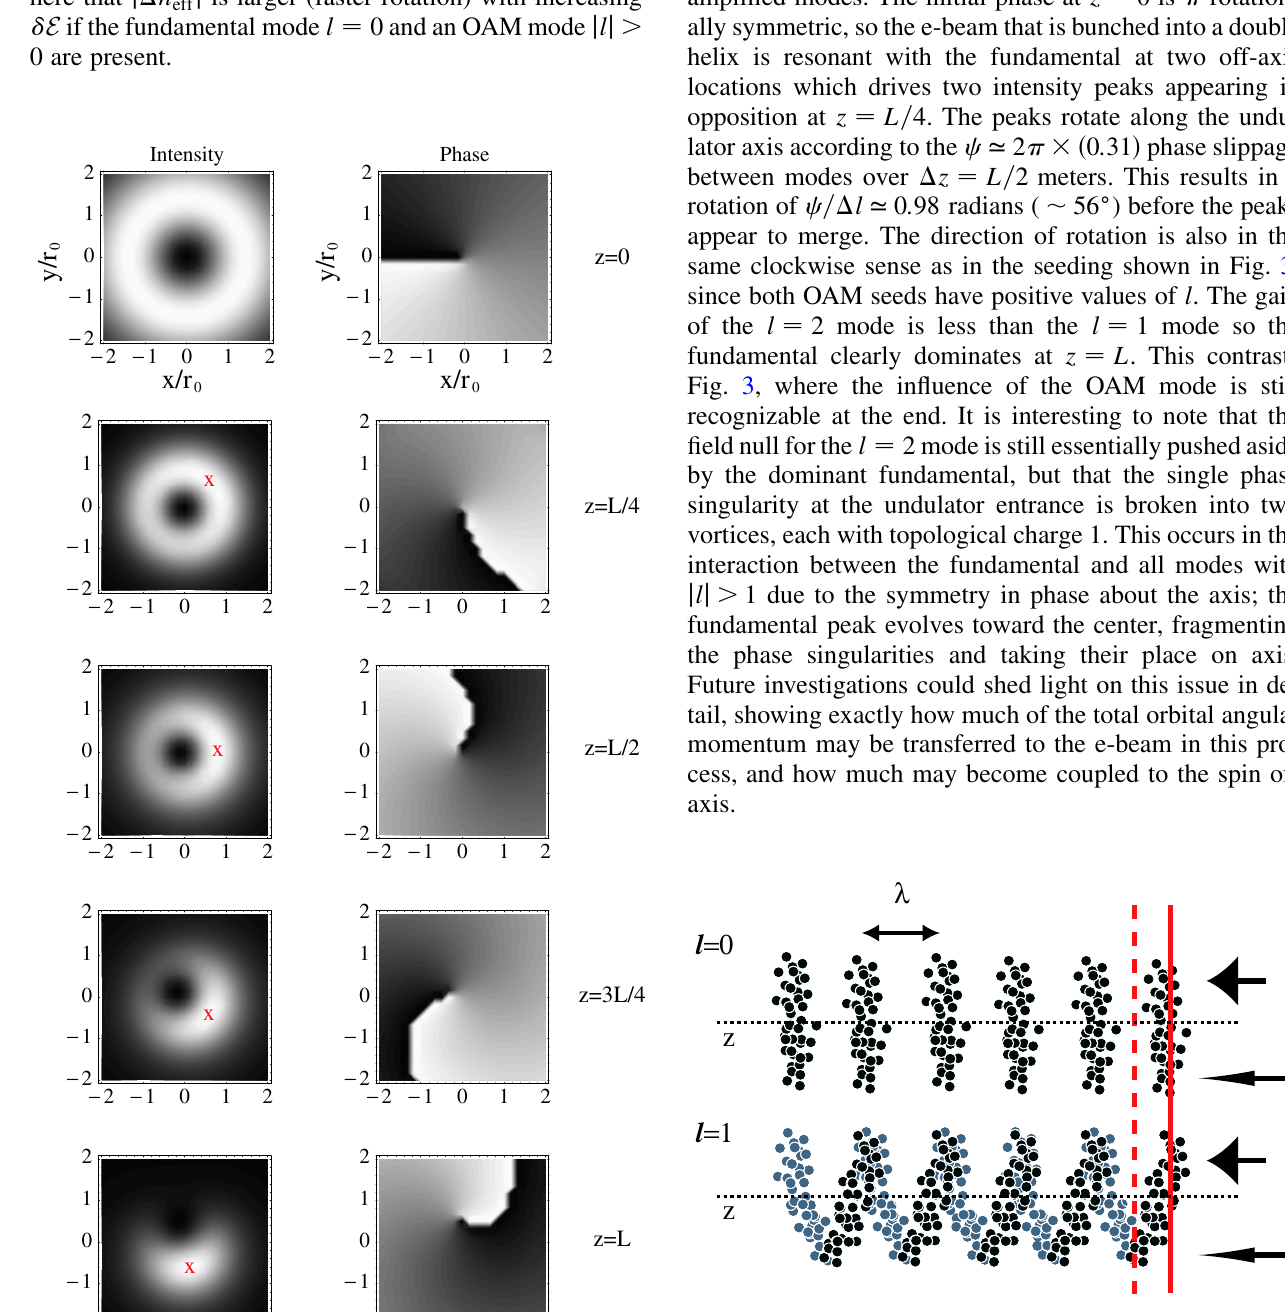
FIG. 4. (Color) Side by side schematic comparison of geometric bunching due to different modes. The fundamental mode (top) tends to generate separate bunches along the z axis. The OAM modes (bottom) tend to bunch the beam in helices due to the azimuthal component of the ponderomotive phase. If both modes are simultaneously present, the electrons on one side of the e- beam (thick arrows) are resonant (solid vertical line), while those in a different transverse position (slender arrows) are bunched out of phase (dashed vertical line). The intensity therefore grows off axis, where the electrons are in